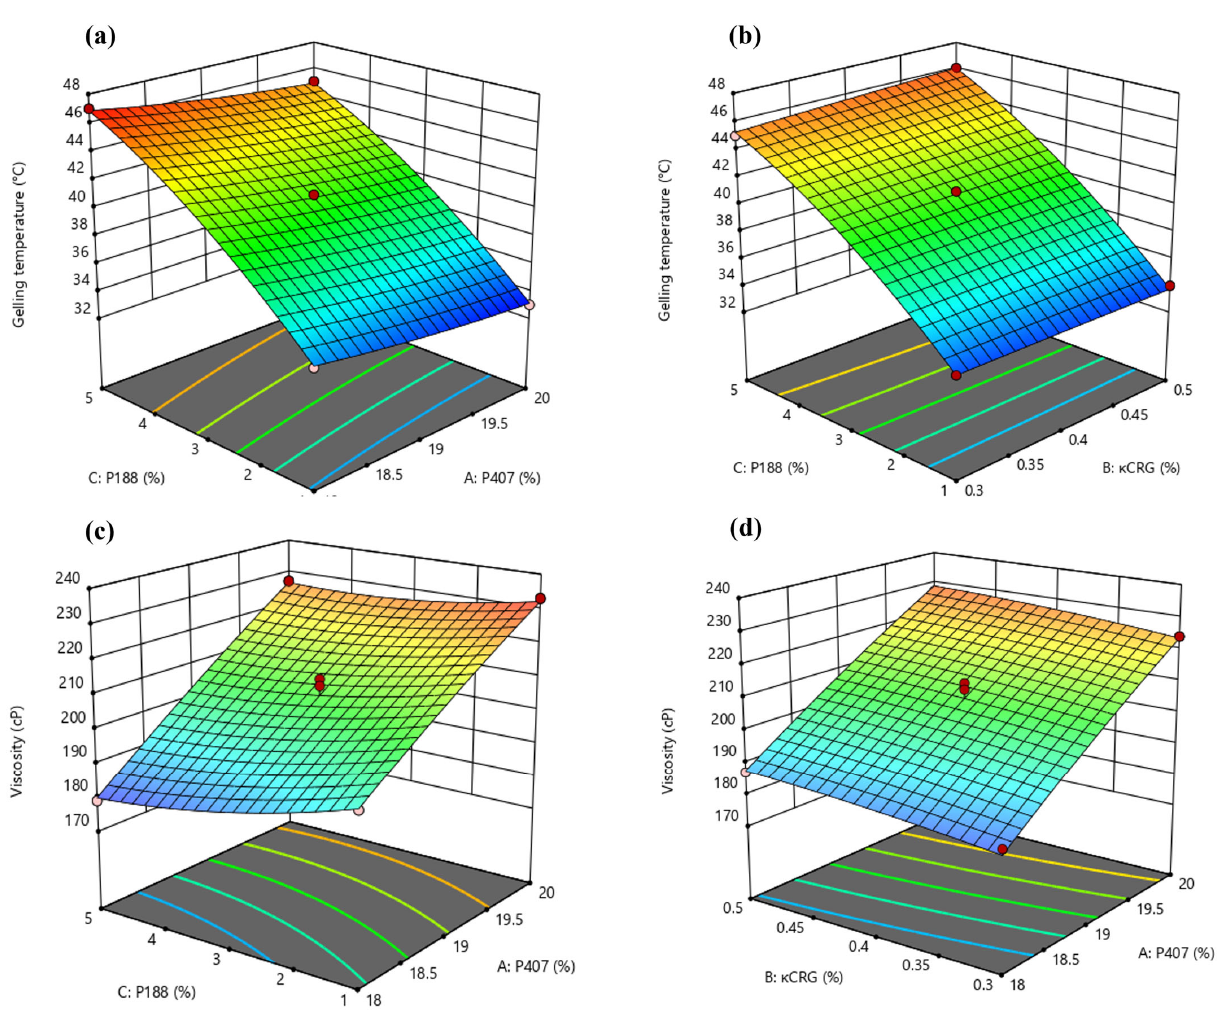
Figure 2. Response surface 3D plots showing the effect of ( a ) concentration of P407 and P188 on gelling temperature; ( b ) concentration of P188 and κ CRG on gelling temperature; ( c ) concentration of P188 and P407 on solution state viscosity and ( d ) concentration of P407 and κ CRG on solution state viscosity of NEB ‐ loaded dual ‐ responsive in situ